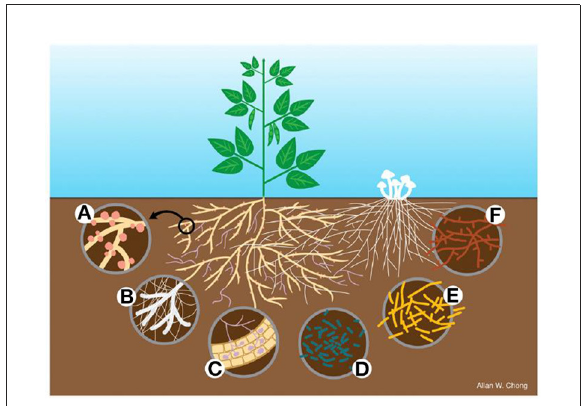
FIGURE1 Root-nodule interactions with microbes. (A) Root nodules on plant roots. (B) Ectomycorrhizal associations with legume tree roots. (C) Arbuscular mycorrhizal interactions with root cells. (D) Gram negative rhizospheric bacteria that may influence nodule formation. (E) Gram positive bacteria colonize both the rhizosphere and the nodules. (F) Free living actinomycetes influence plant growth by nitrogen fixation among others. Adapted from Martínez-Hidalgo and Hirsch (2017).